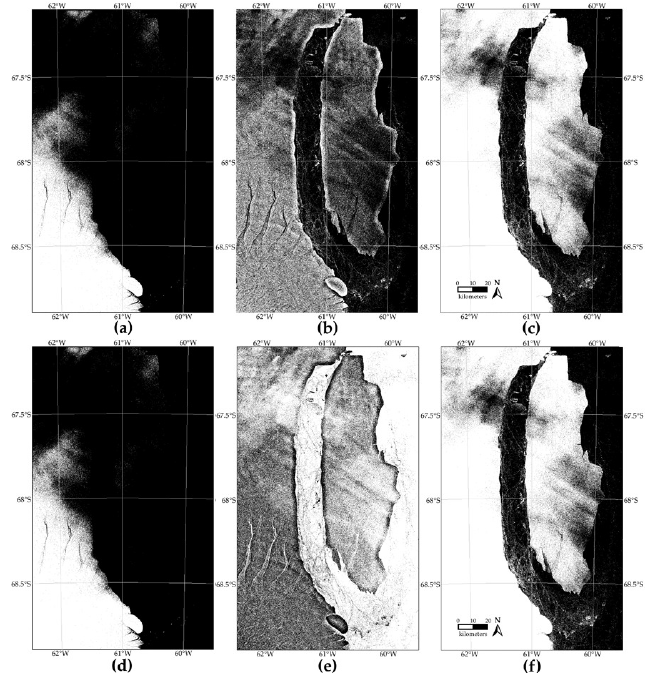
Figure 3. Effect of the contrast enhancement algorithm on the segmentation stage. The applied fuzzy algorithm was compared with alternative contrast enhancement solutions (see Section 4.1)